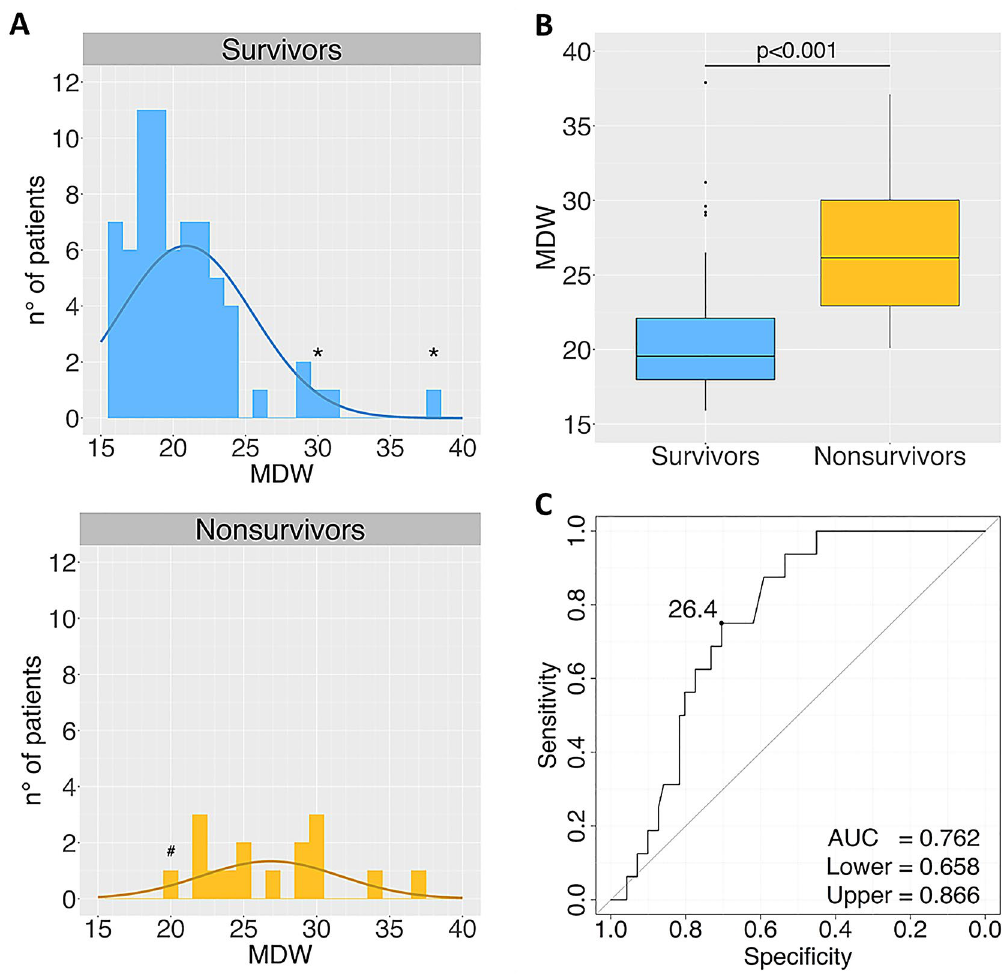
Figure 2. MDW correlations with clinical outcome in COVID-19 patients. ( A ) Distribution of last MDW values detected in COVID-19 patients (n = 87), segregated into different outcome groups (discharged/alive vs deceased patients, upper and lower graphs, respectively), as defined at time of censoring. In some cases (*), MDW measurement was lastly performed during critical phases, either in patients with ongoing severe disease (alive at time of censoring), or in patients with a subsequent full recovery but, unfortunately, without any further MDW measurements available. Vice versa, a negative MDW value (< 20.5) was lastly recorded in a patient (#) with complete recovery from hyper-inflammatory pneumonia, who suddenly had fatal event (stroke). ( B ) Boxplot comparison for ‘last MDW’ median values between survivor and non-survivor groups. ( C ) ROC curve for final outcome in COVID-19 patients (n = 87) using MDW test (threshold,